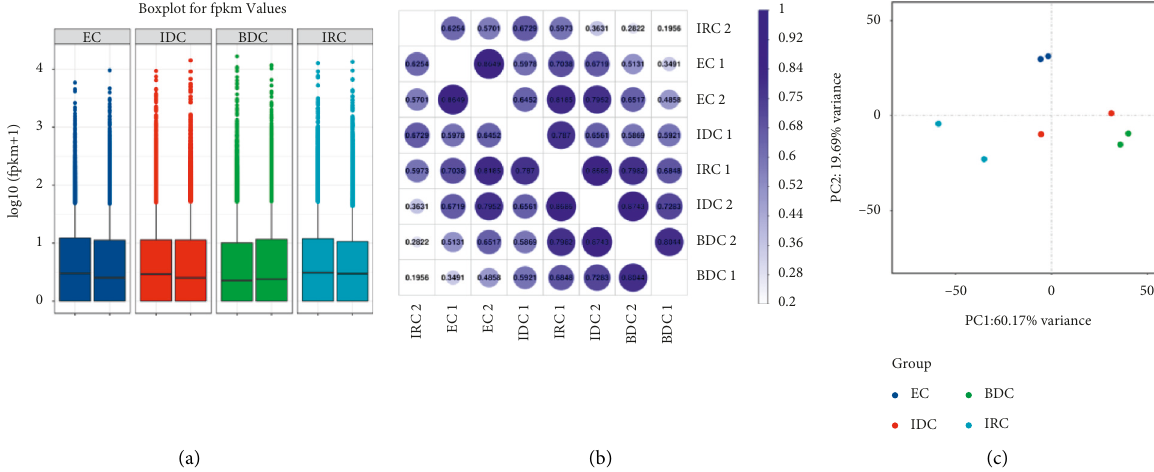
Figure 2: Gene expression changes in different states callus. (a) Boxplot of gene expression level. The x-coordinate is the sample name; the y- coordinate is log10 (FPKM +1). Gene expressions of each sample are shown in table under the boxplot. (b) Heat map of correlation coefficient between samples. (c) Principal component analysis for normalized reads for all 8